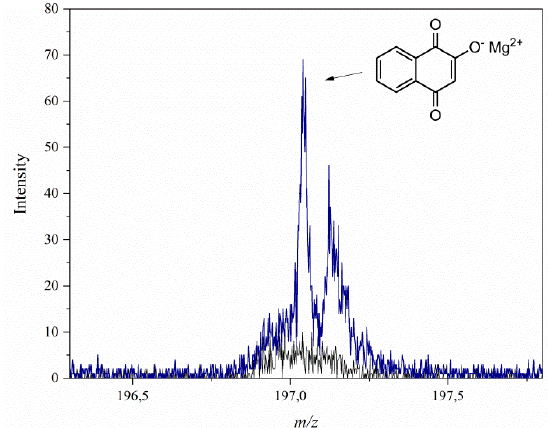
Figure 2. TOF-SIMS spectra of the LH (black line) and LH / lawsone pigment (blue line).